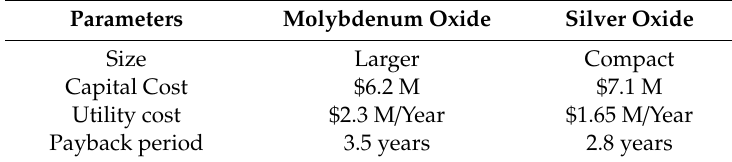
Table 6. Catalyst performance parameters.